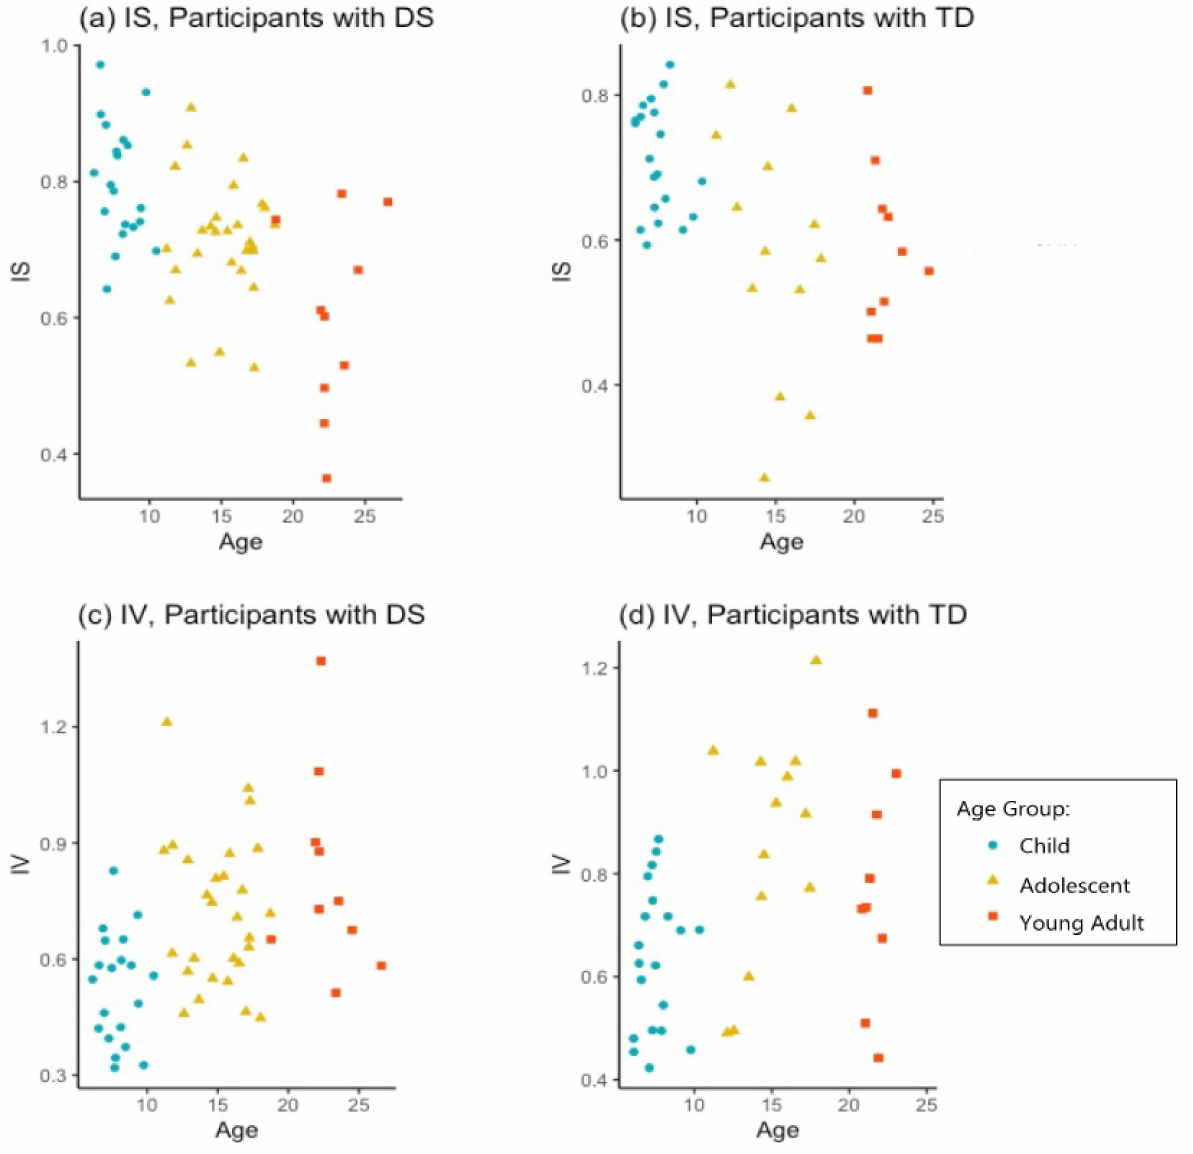
Figure 3. IS and IV across ages. ( a ) IS for individuals with DS declined from childhood through young adulthood, indicating less stability. ( b ) IS for individuals with TD declined for adolescents but did not decline further for young adults. ( c ) IV increased in individuals with DS, indicating more randomness in within-day sleep-wake transitions, from childhood through adulthood. ( d ) IV in individuals with TD was highest for adolescents, but less random for young